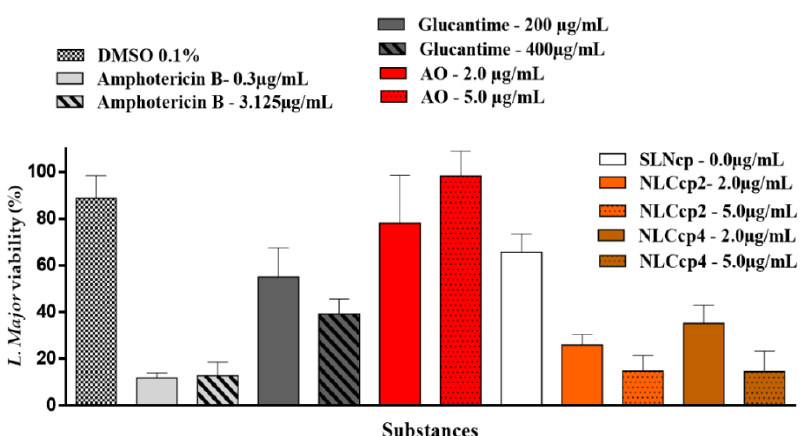
Figure 9. L. major viability using macrophages infected with L. major and treated with antileishmanial drugs, AO, and nanoparticles with and without AO. Mean ± sd, n =